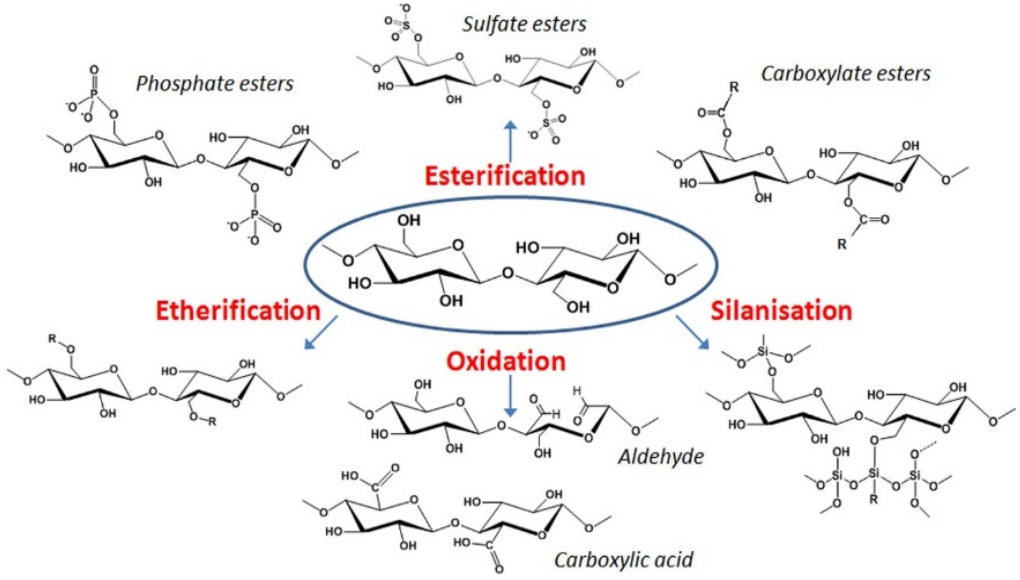
Figure 4. Chemical modifications of BC. Reprinted with permission from [23]. Copyright (2017) Elsevier.